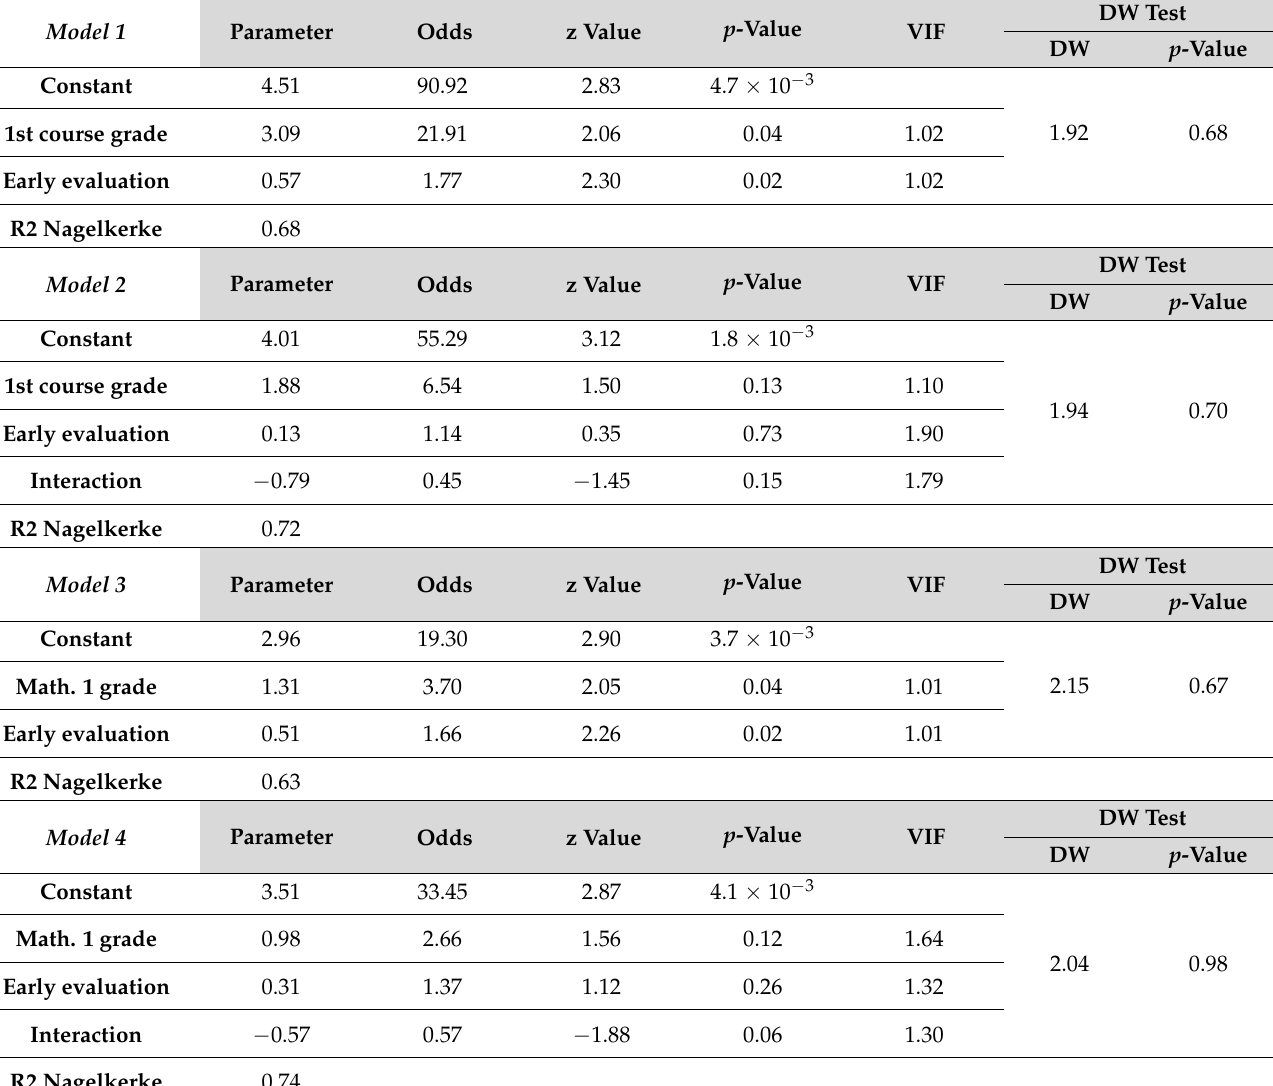
Table 4. Adjustment of the four selected models, including variance inflation factors (VIFs) and the Durbin–Watson autocorrelation